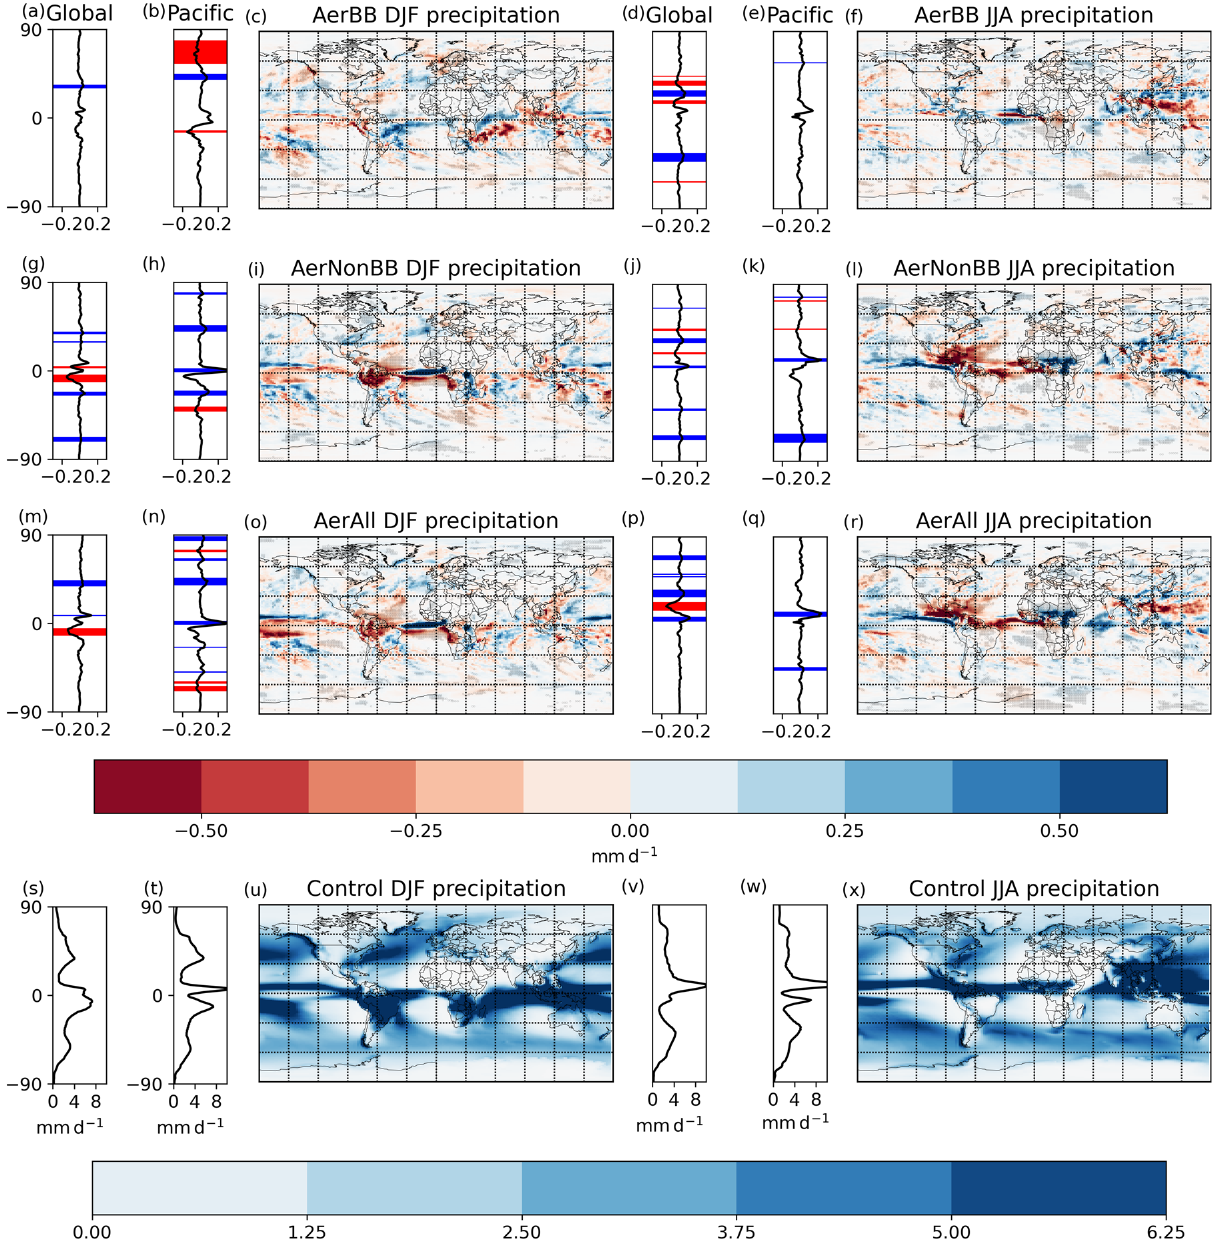
Figure 7. Precipitation response from 2070–2100 in AerBB (a–f) , AerNonBB (g–l) , and AerAll (m–r) for DJF (left) and JJA (right), with maps and zonally both globally and across the Pacific (150–270 ◦ E). Control DJF and JJA precipitation maps are shown at the bottom. Stippling on the maps indicates grid cells where the change is significant with respect to intra-ensemble variation. The coloured areas in the zonal change panels show significance – red for decreased and blue for increased